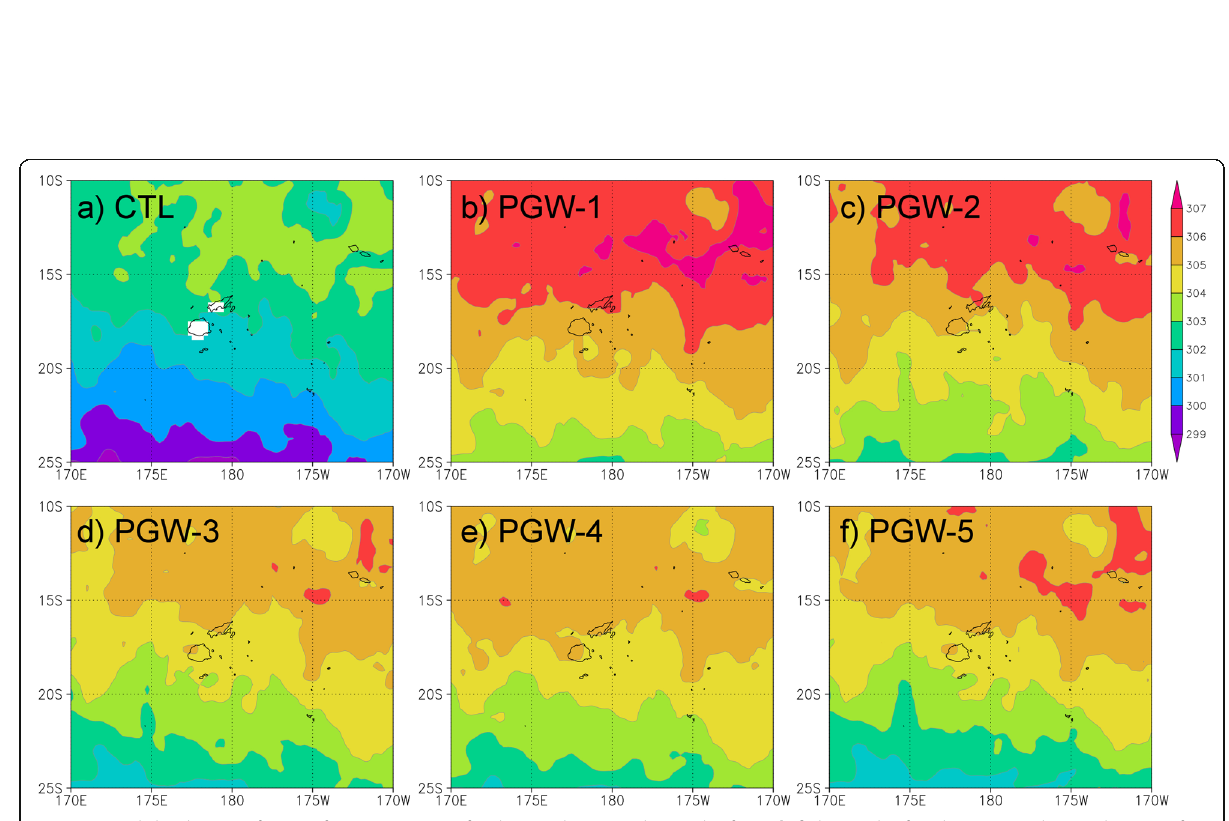
Fig. 4 Spatial distribution of sea surface temperature for the initial time. a The result of CTL. b - f The result of each PGW simulation. The unit of the color bar is